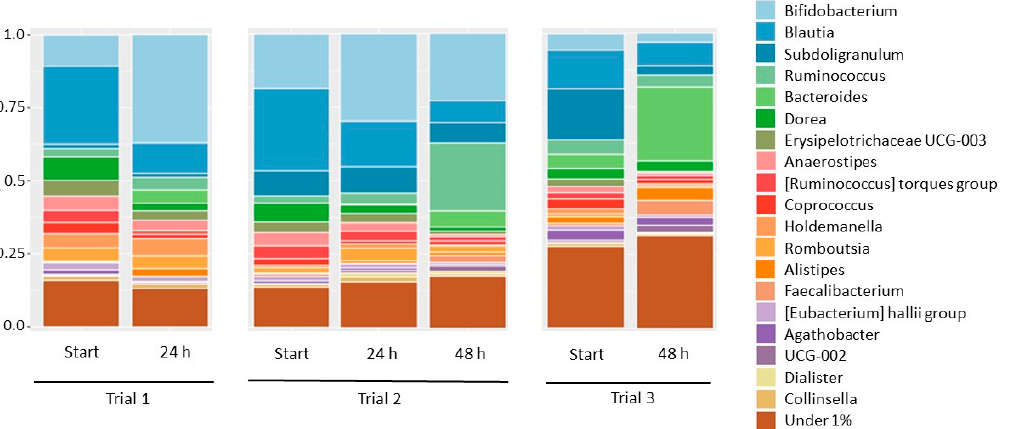
Figure 5. Microbial composition of starting, intermediate and end inocula of the different in vitro fermentation trials. The fecal inocula were enriched with ADC25 (Trial 1) and ADC27 (Trial 2, Trial 3).